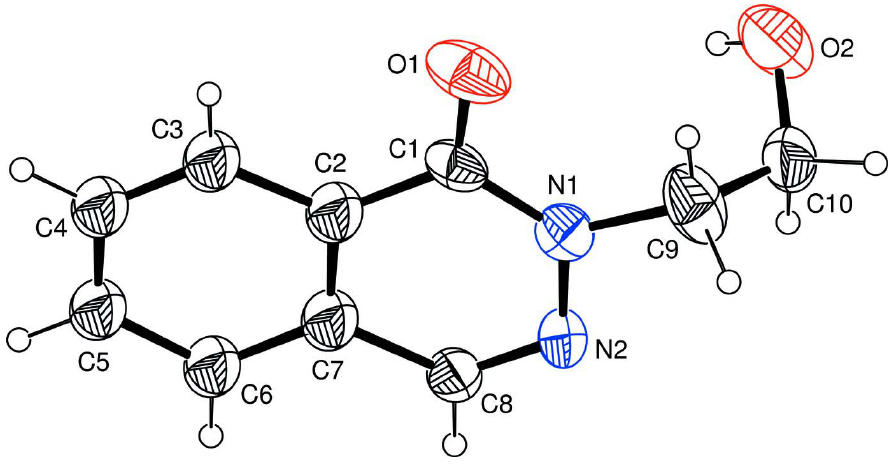
Figure 1 The molecular structure of the title molecule, with the atom-numbering scheme. Displacement ellipsoids are drawn at the 30% probability level.